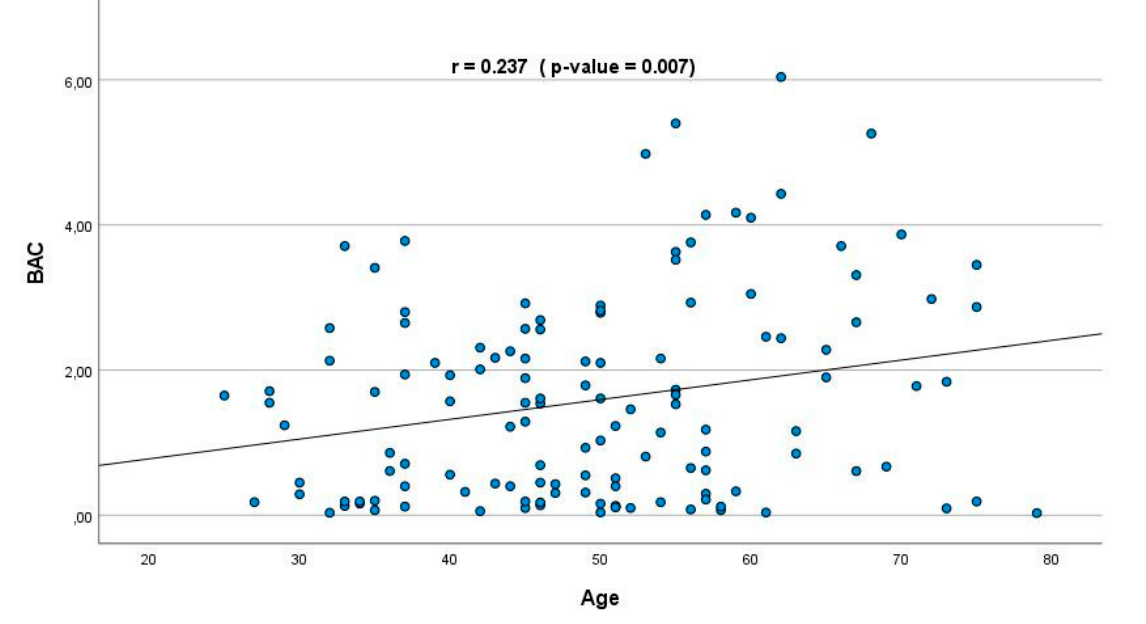
Figure 2. Positive association in whole series among age and blood alcohol concentrations (BAC; g/L). r = 0.237; p = 0.007; Pearson’s linear correlation coefficient.